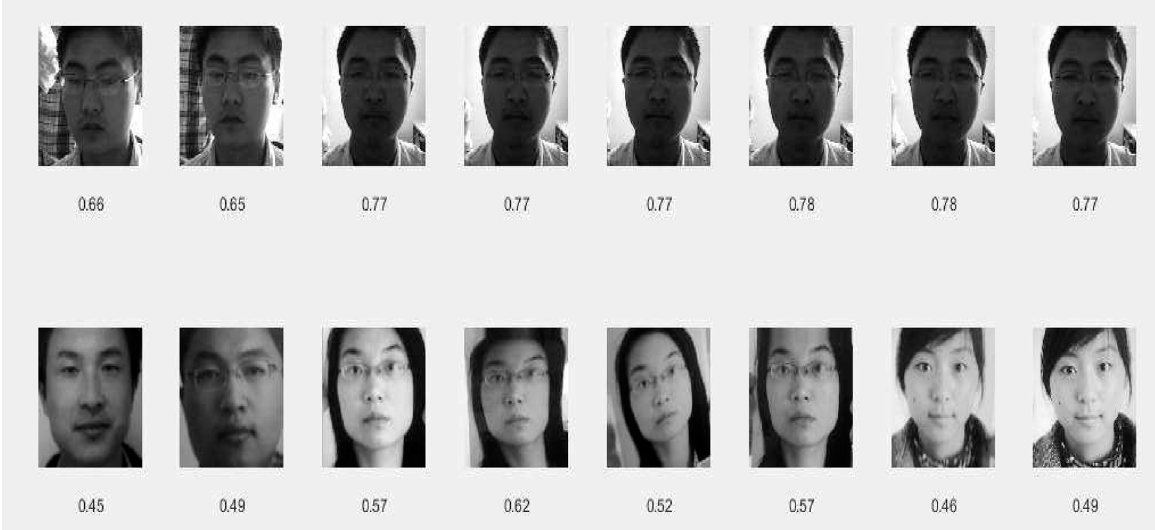
Fig. 6 Real and planar prints with contrast scores as per Eqn. (4)